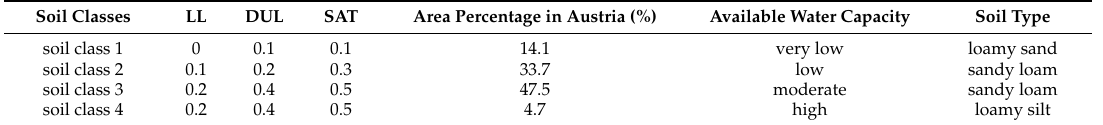
Table 1. Four soil classes according to the available water capacity for Austria.